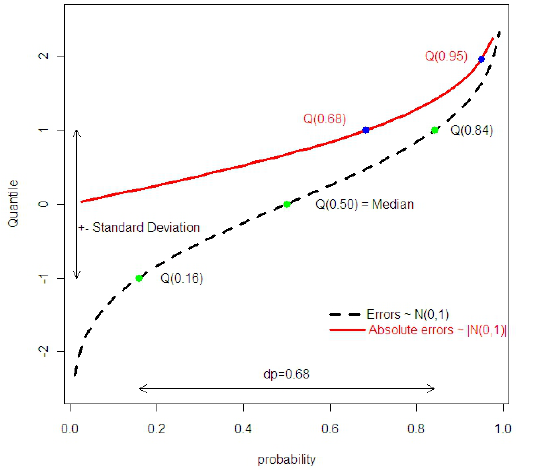
Figure 2. Robust accuracy measures: Median, Q(0.68), and Q(0.95). The quantile function Q(p) for absolute errors (red line) shows that Q(0.68) corresponds to 1· σ in case of normal distribution. When original errors are used (stippled black line) the difference dp=0.68 corresponds to the range of ±1· σ .